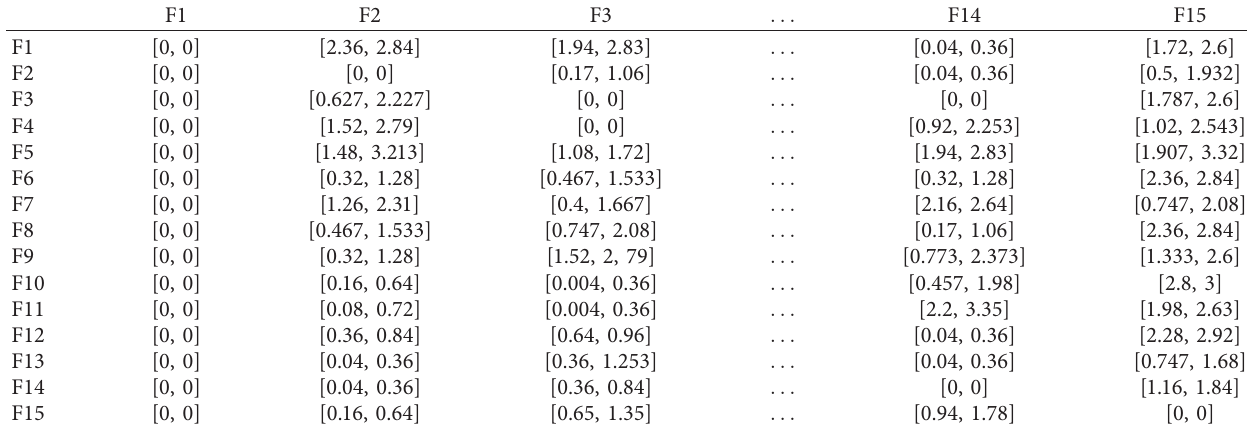
Table 3: The rough group direct-relation matrix of land-lost farmers’ happiness.